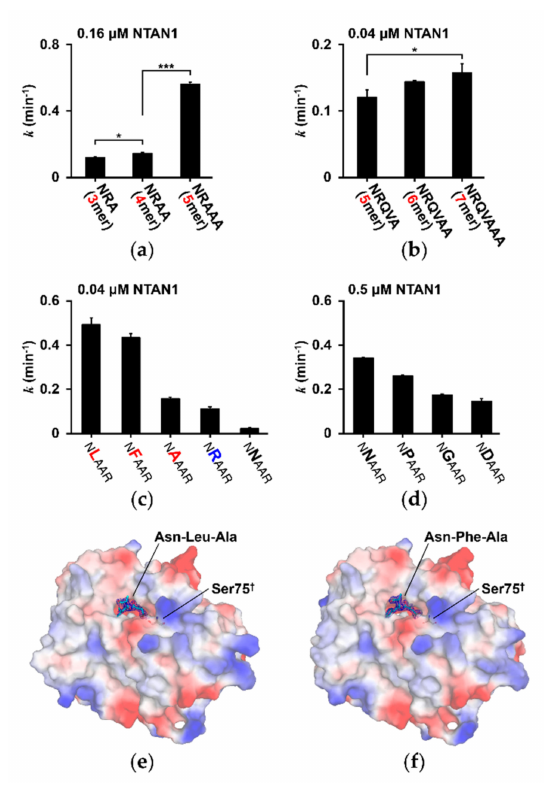
Figure 2. NTAN1 shows di ff erent deamidation rates on various Nt-Asn peptides. ( a ) Deamidation rates of NRA, NRAA, and NRAAA peptides for 0.16 µ M NTAN1. Deamidation coe ffi cient was obtained from the slope when the logarithmic concentrations of the substrates were plotted against incubation times. p values were determined using Bonferroni’s multiple comparison test; *** p < 0.005, * p < 0.05). Error bars indicate standard-deviation values of three independent experiments. ( b ) Deamidation rate of NRQVA, NRQVAA, and NRQVAAA peptides for 0.04 µ M NTAN1. ( c ) Deamidation rates of NXAAR peptides measured with 0.04 µ M NTAN1, where the second-position X represents Leu (L), Phe (F), Ala (A), Arg (R), and Asn (N). The hydrophobic and basic residues in second-position are labeled in red and blue, respectively. ( d ) Deamidation rates of NXAAR peptides measured with 0.5 µ M NTAN1, where the second-position X represents Asn (N), Pro (P), Gly (G), and Asp (D). ( e , f ) Electrostatic surface of NTAN1 C75S mutant structures in complex with NLAAR ( e ) and NFAAR ( f ) pentapeptides. Catalytic Cys75 residues mutated to Ser75 are labeled with daggers. The positively, negatively, and neutrally charged surfaces are colored in blue, red, and white, respectively. Three amino acid residues with definitive electron density from the N-terminus of the pentapeptides are shown as stick models and colored in cyan and the electron densities of mFo - DFc omit maps are represented by blue meshes at a 3.0 σ contour